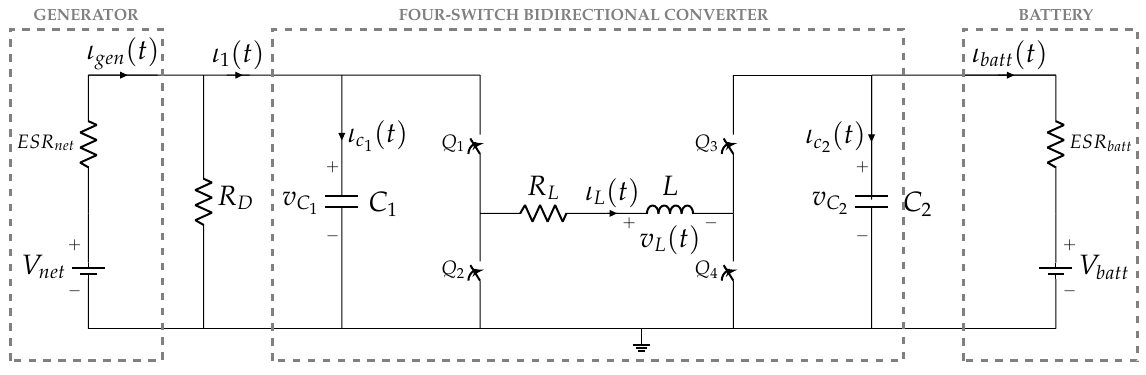
Figure 1. Schematic of the electrical power